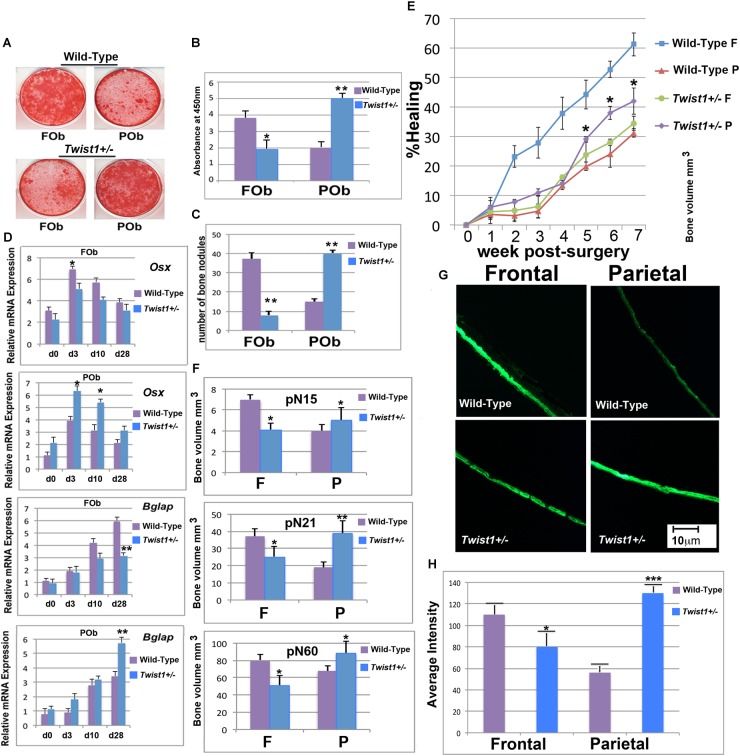
Twist1 haploinsufficiency enhances the osteoskeletal potential of mesoderm-derived parietal bone. (A) FOb and POb cultured under osteogenic conditions for 28 days and stained with Alizarin Red. (B) Quantification of Alizarin Red staining revealing a more intense mineralization of the extracellular matrix in Twist1+/− POb as compared to wild-type POb. (C) Number of large bone nodules formation identified by von-Kossa staining at osteogenic differentiation day 28. (D) Relative mRNA expression of early (Osx) and late (Bglap) osteogenic markers in wild-type and Twist1+/− osteoblasts cultures. Results are representative of three experiments performed. (E) Time course of frontal and parietal bone healing defects, quantification of defect repair (n? = ?5/each bone) based on μCT results are analyzed using magic wand tool in Photoshop after standardization of threshold for regenerating calvarial bone. Results are representative of two independent experiments performed. Statistical analysis was performed using the Mann–Whitney Test. ∗P ≤ 0.05. (F) Quantification of bone thickness in uninjured wild type and Twist1+/− Frontal and Parietal bones ∗P ≤ 0.05. (G) Bone formation in wild-type and Twist1+/− frontal and parietal bones assessed by culturing skulls for 48 h in presence of calcein (1 μg/ml). (H) Quantification of calcein incorporation. Histomorphometric analysis of calcein accumulation was obtained using Image J64 densitometry analysis. Scale bar, 10 μm. Results are representative of three independent experiments performed. Values: ∗p ≤ 0.05, ∗∗p ≤ 0.01, and ∗∗∗p ≤ 0.001.